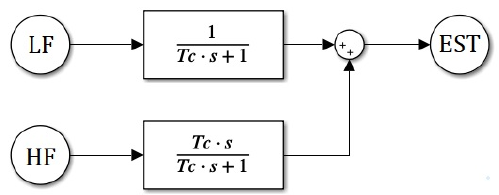
Figure 2. Complementary filter diagram.